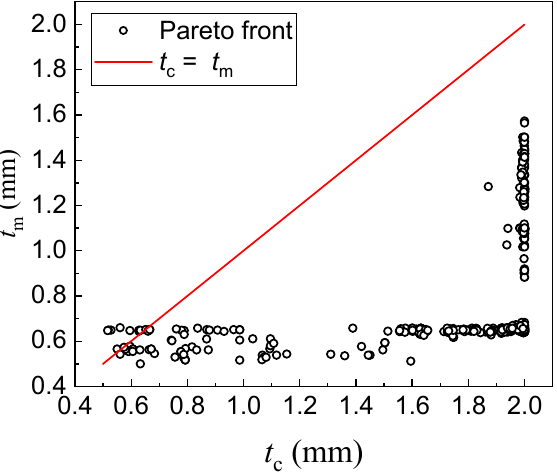
Figure 13. Distribution of t c v.s. t m of the Pareto fronts.